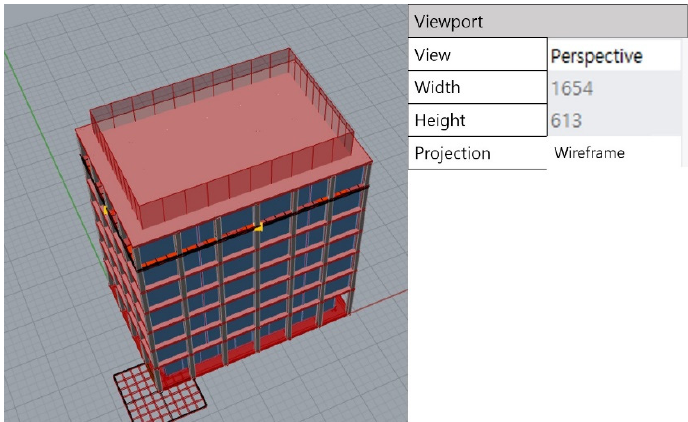
Figure 5. Generated Model with Dimensional Information.